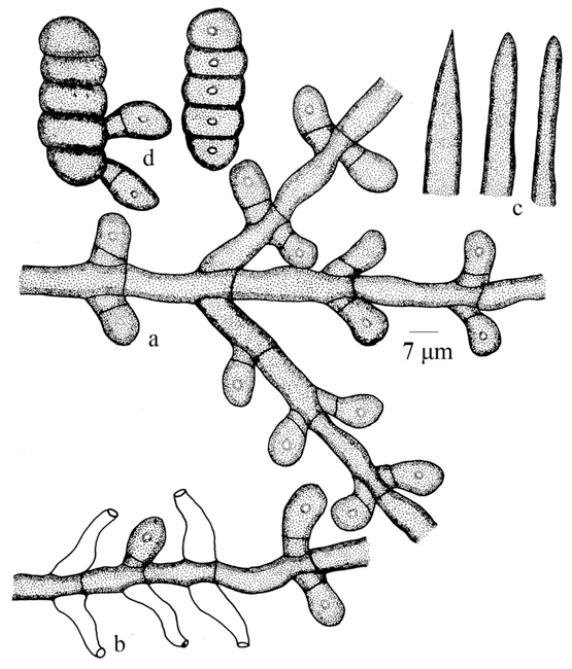
Figure 8. Meliola andamanica sp. nov. a - Appressorium; b - Phialide; c - Apical portion of the mycelial setae; d -